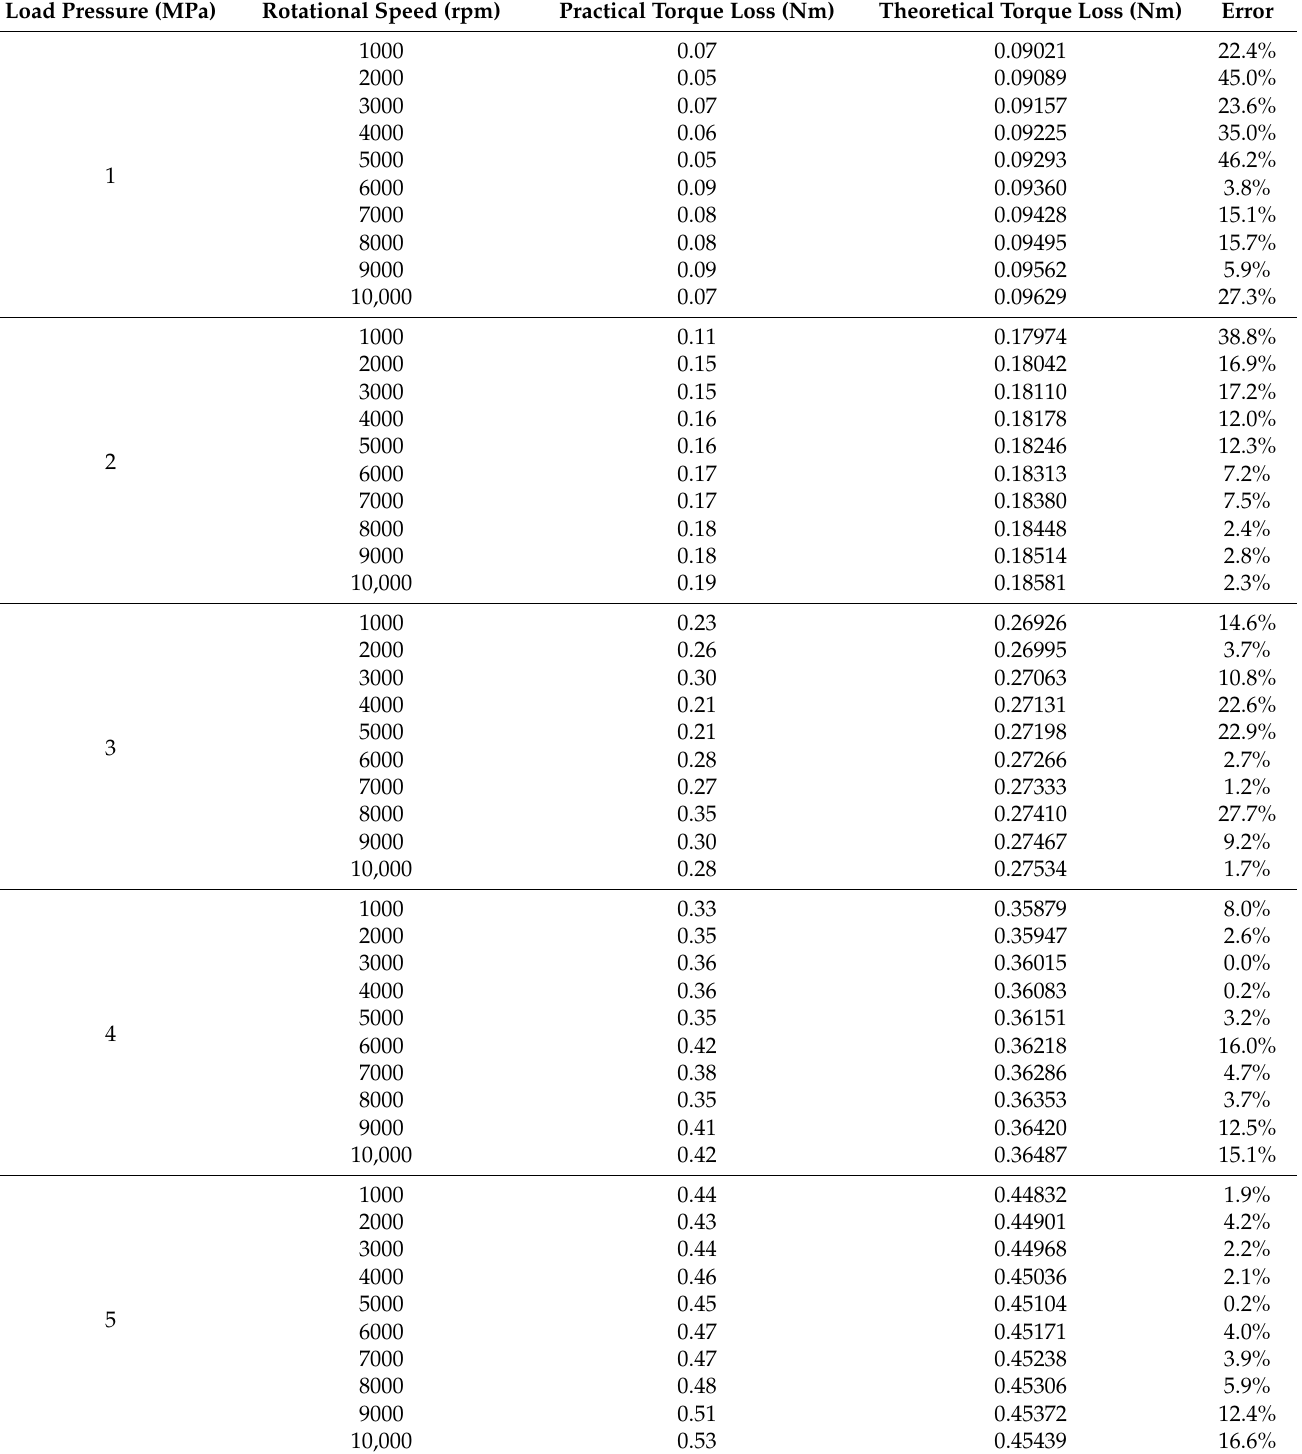
Table 3. Error between the practical torque loss and theoretical torque